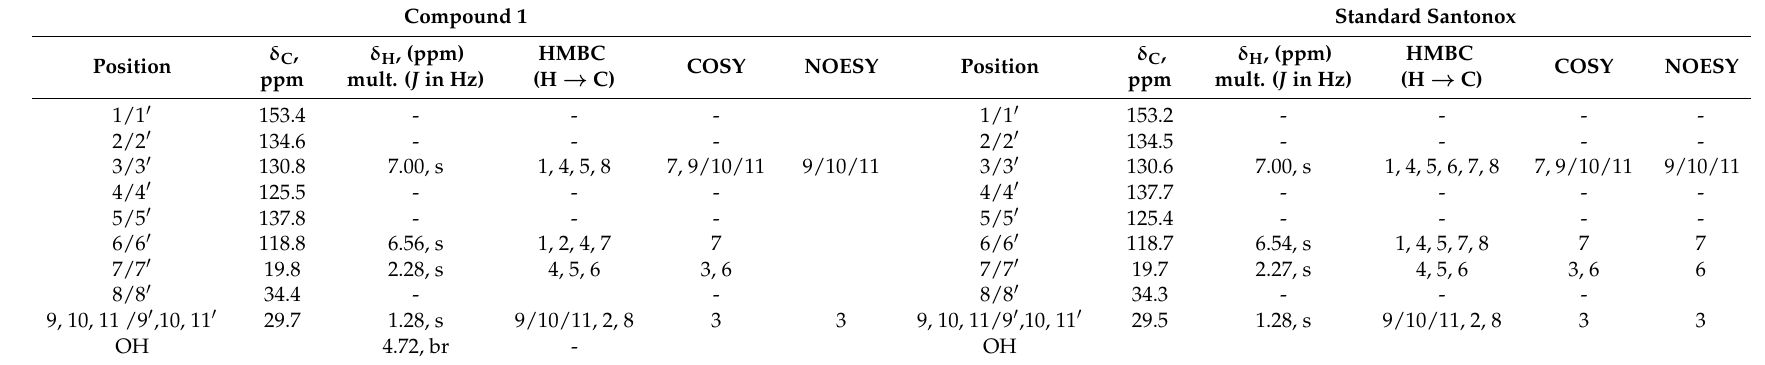
Table 1. One-dimensional (1D) and two-dimensional (2D) NMR data for Compound 1 and standard Santonox in CDCl 3 (300 MHz for 1 H-NMR, and 75 MHz for 13